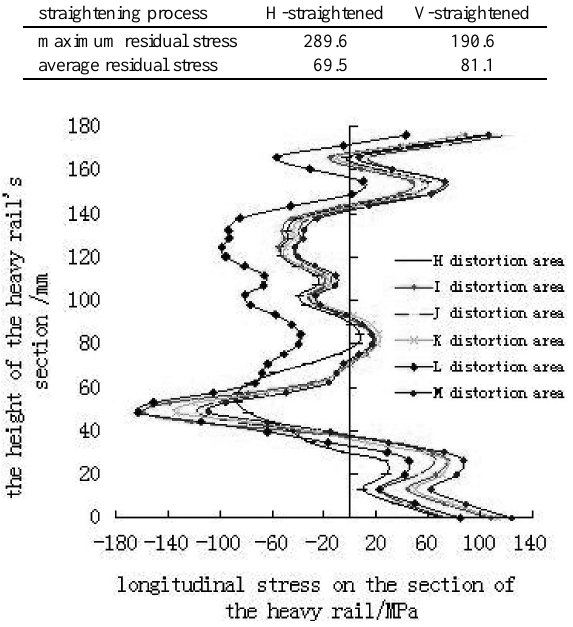
Fig. 8. The residual stress changing of rail section’s symmetry line when